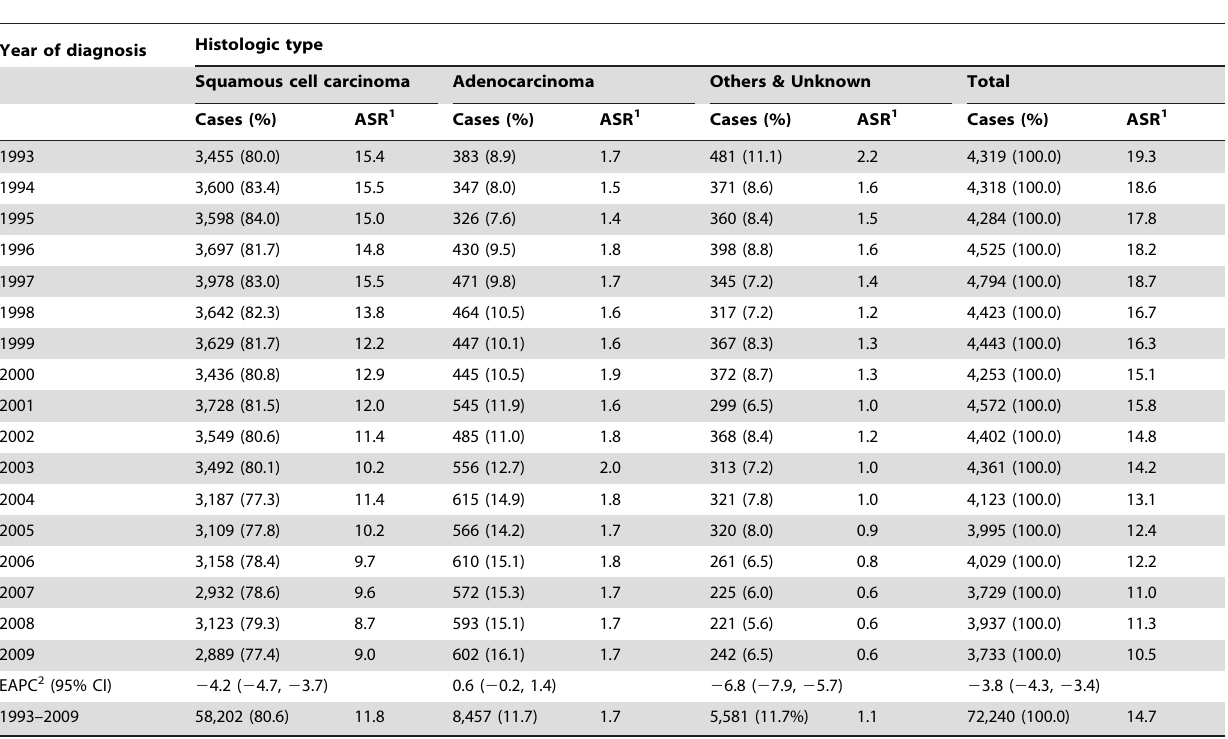
Table 1. Numbers and age standardized rates of invasive cervical cancer by year of diagnosis, and histologic type, Korea, 1993–